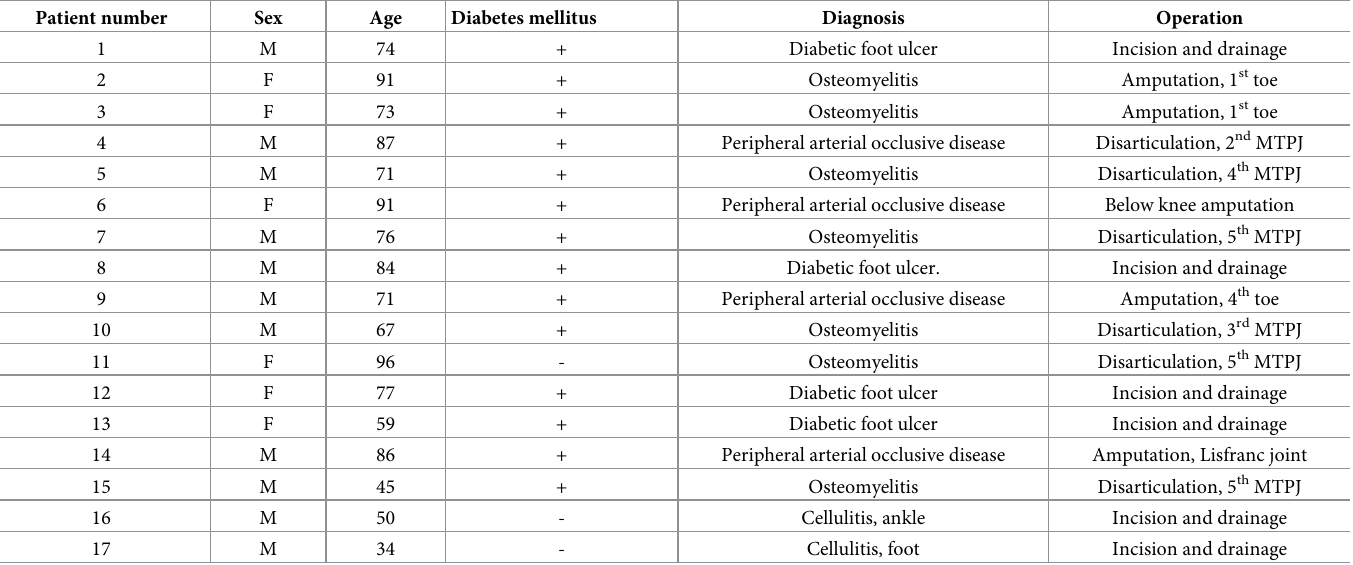
Table 1. Baseline characteristics of the surgery group in the present study.